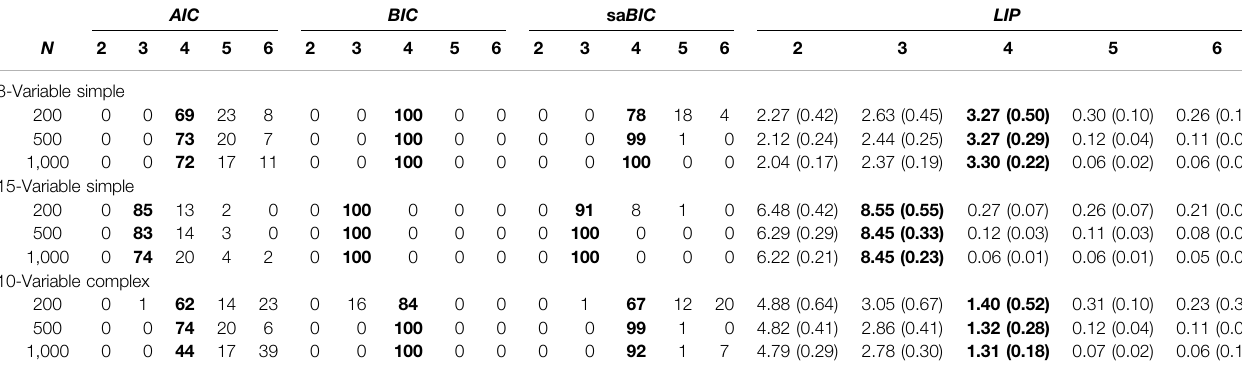
Columnsrepresentlatentpro fi lemodelswithadifferentnumberofclasses,valuesfortheinformationcriteriarepresentthepercentofreplicateswherethemodelhadthelowestinformation criteria, AIC (cid:2) AkaikeInformationCriterion, BIC (cid:2) BayesianInformationCriterion, saBIC (cid:2) SampleSizeAdjustedBayesianInformationCriterion, LIP (cid:2) LikelihoodIncrementPercentage, LIP values are mean values across replicates with the standard deviation across replicates within parentheses for comparing the model with one fewer class. Bolded columns indicate the number of classes in the population.